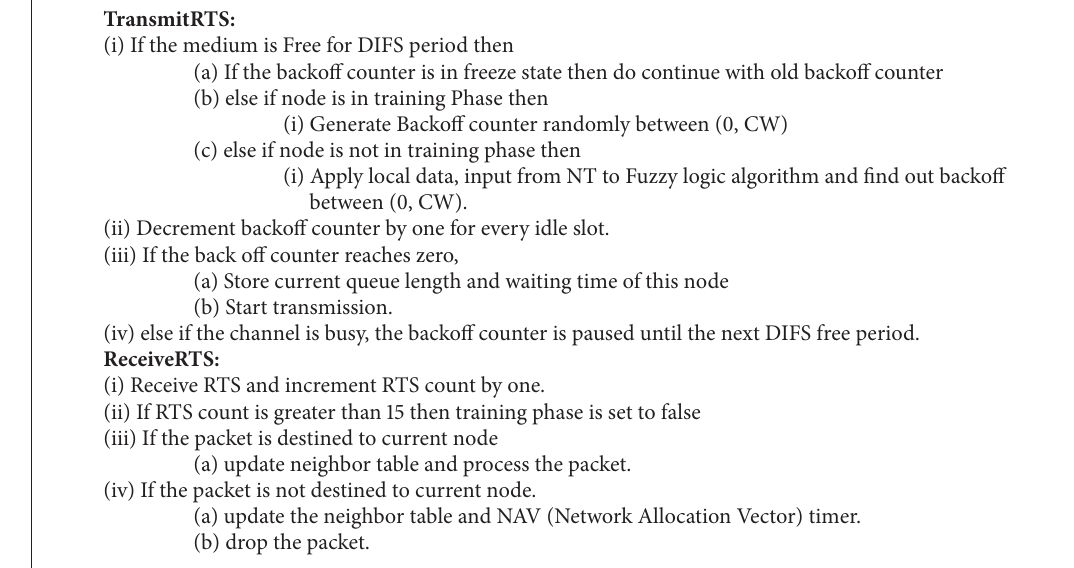
Algorithm 1: Steps to be followed while transmitting and receiving